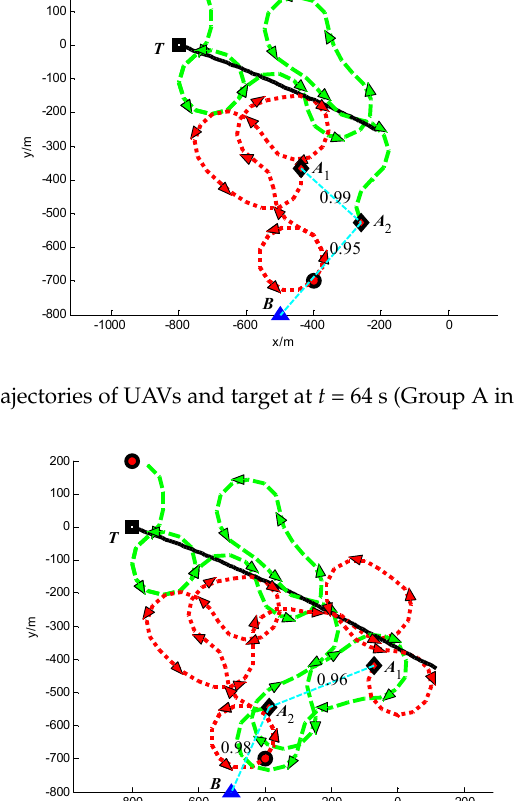
Figure 8. Trajectories of UAVs and target at t = 100 s (Group A in Scenario 1).